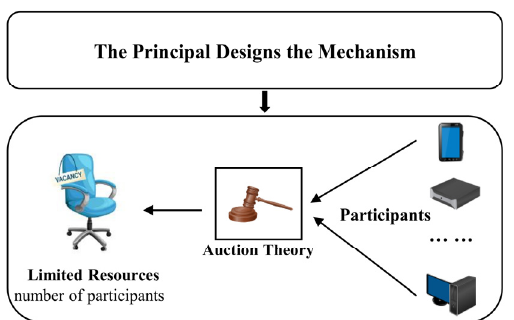
Figure 2. The relationship between mechanism design and auction theory in federated learning.